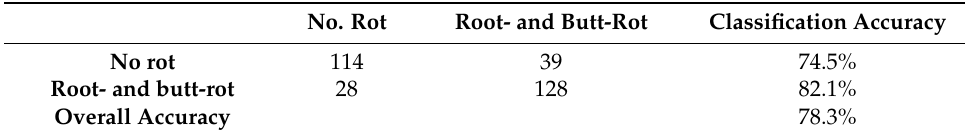
Table 3. Confusion matrix for the classification of presence or absence of root- and butt-rot on the tree-stumps.